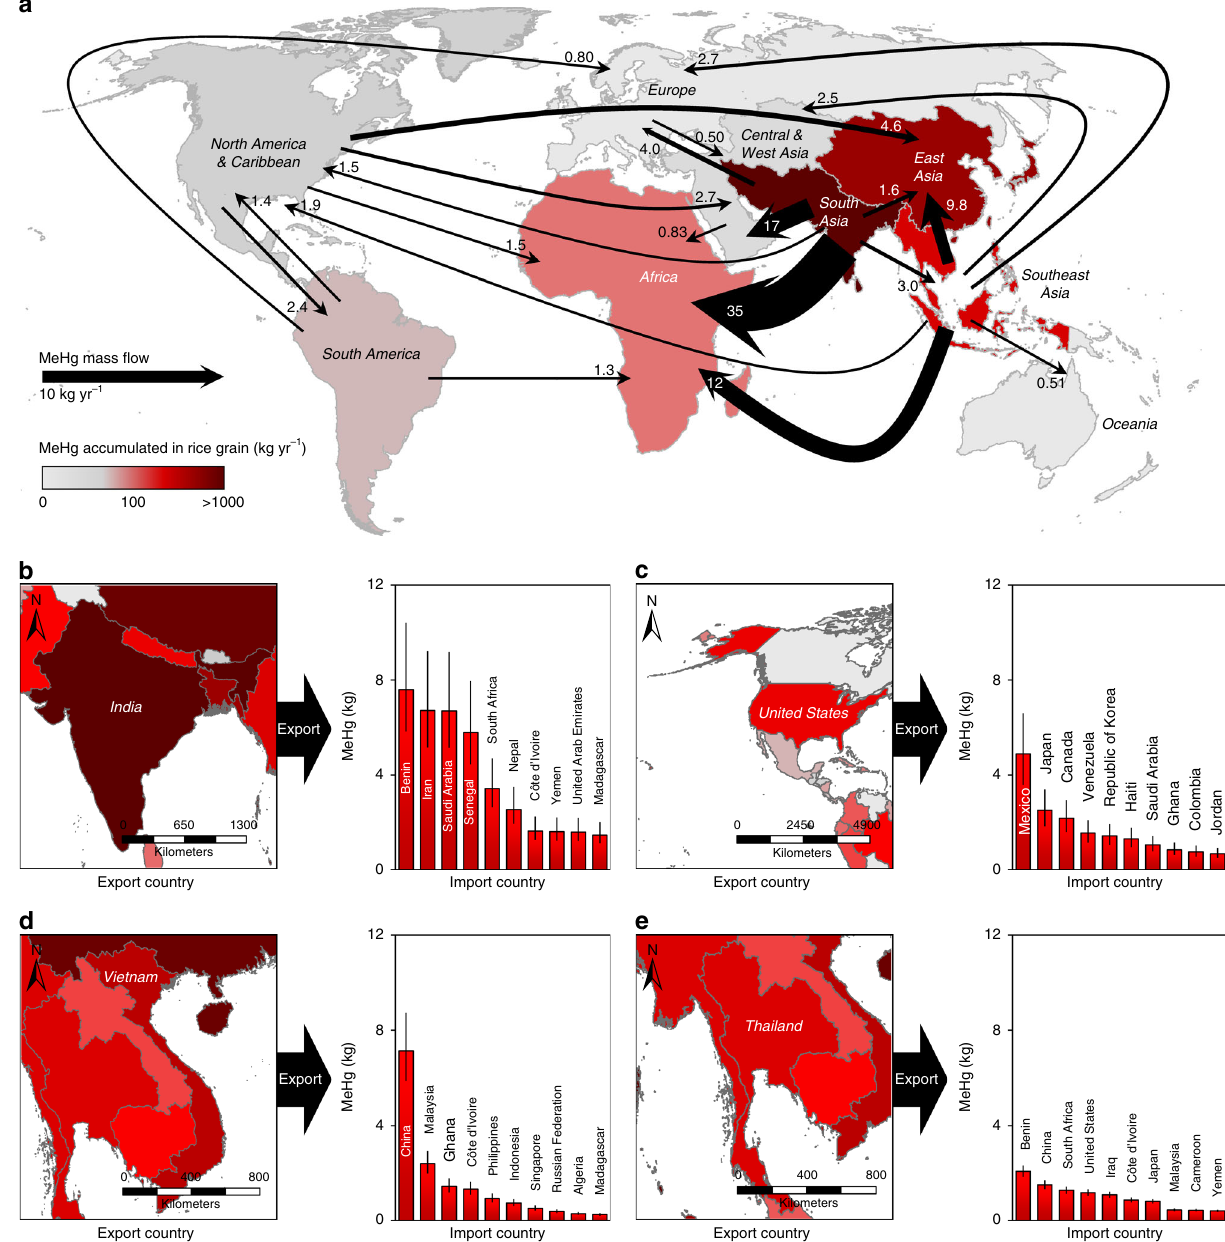
Fig. 5 Global biotransport of methylmercury through the international rice trade. a shows the major MeHg fl ows (>0.5 kg yr − 1 ) induced by the international rice trade between the regions. b – e show the top ten partner countries of the major rice MeHg-exporting countries, i.e., India ( b ), the United States ( c ), Vietnam ( d ), and Thailand ( e ), respectively. Data are in 2013. Error bars in fi gures represent the interquartile range of the con fi dence